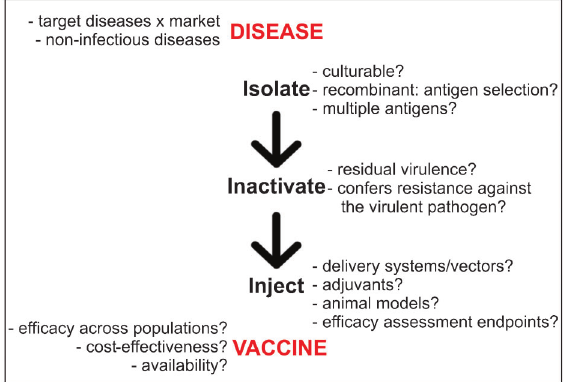
Figure 1. Issues regarding the development of new vaccine strategies. The Pasteur paradigm is highlighted in bold. Issues in vaccine development that are found in the successful accom- plishment of each step are highlighted laterally. On the left : some issues of vaccine development are beyond the challenges involved in following the Pasteur paradigm. The choice of